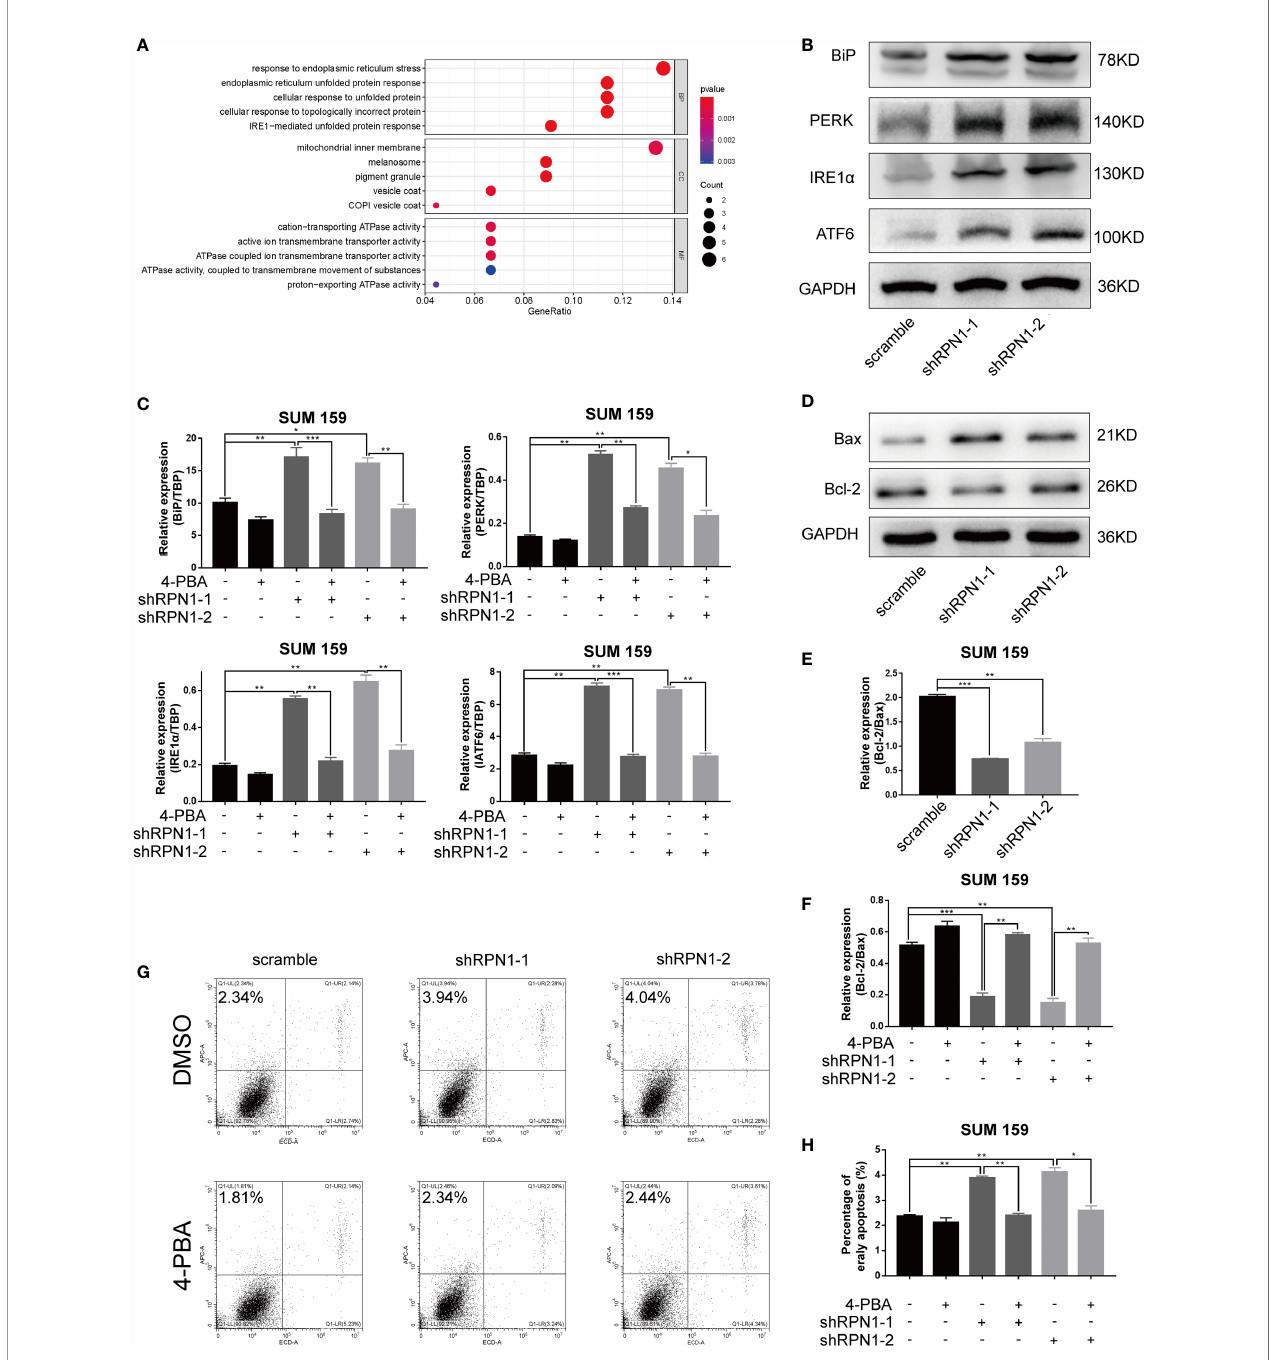
FIGURE 8 | ERS-dependent apoptosis was triggered by the knockdown of RPN1. (A) Bubble plot of the GO function enrichment analysis of the genes positively correlated with RPN1 RNA expression level in BLBC. Y-axis represents the name of the function, and X-axis represents the ratio of the number of the genes assigned to a term to the total number of the genes. The Bubble size represents the number of the genes annotated to the function. The color of the bubble represents the enriched P-value, while the red indicates a greater signi fi cance level. (B) The expression of ERS-related proteins was detected by western blot in SUM159 cells. (C) Scramble and shRPN1-infuected SUM159 cells were treated with 4-PBA (2 uM) or same volume of DMSO for 48 h, and the ERS markers were determined by qRT-PCR. (D, E) The protein expression of Bax and Bcl-2 in SUM159 detected by western blot and the ratio of the protein expression of Bcl-2 and Bax were also shown. (F) The ratio of the mRNA expression level of Bcl-2 and Bax was determined by qRT-PCR in 4-PBA- or DMSO-treated SUM159 cells. (G, H) Apoptosis analyzed by fl ow cytometry in 4-PBA- or DMSO-treated SUM159 cells. *P < 0.05, **P < 0.01 and ***P < 0.001. BP, Biological process; CC, cellular component; MF, molecular function; 4-PBA, Sodium